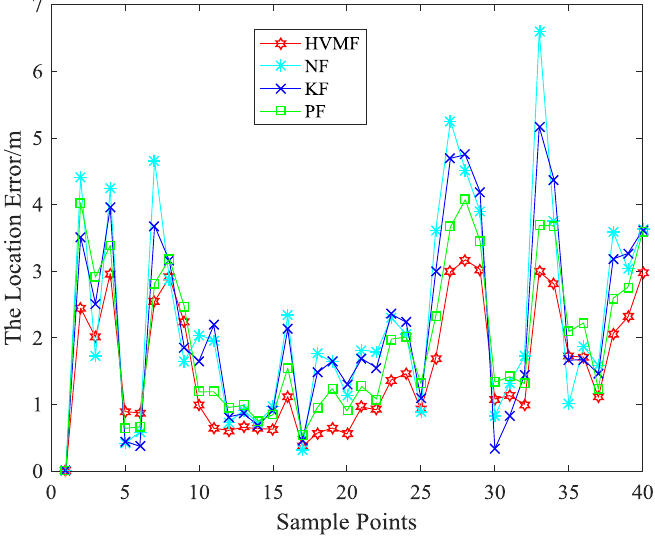
Figure 21. The localization error in each sample point.